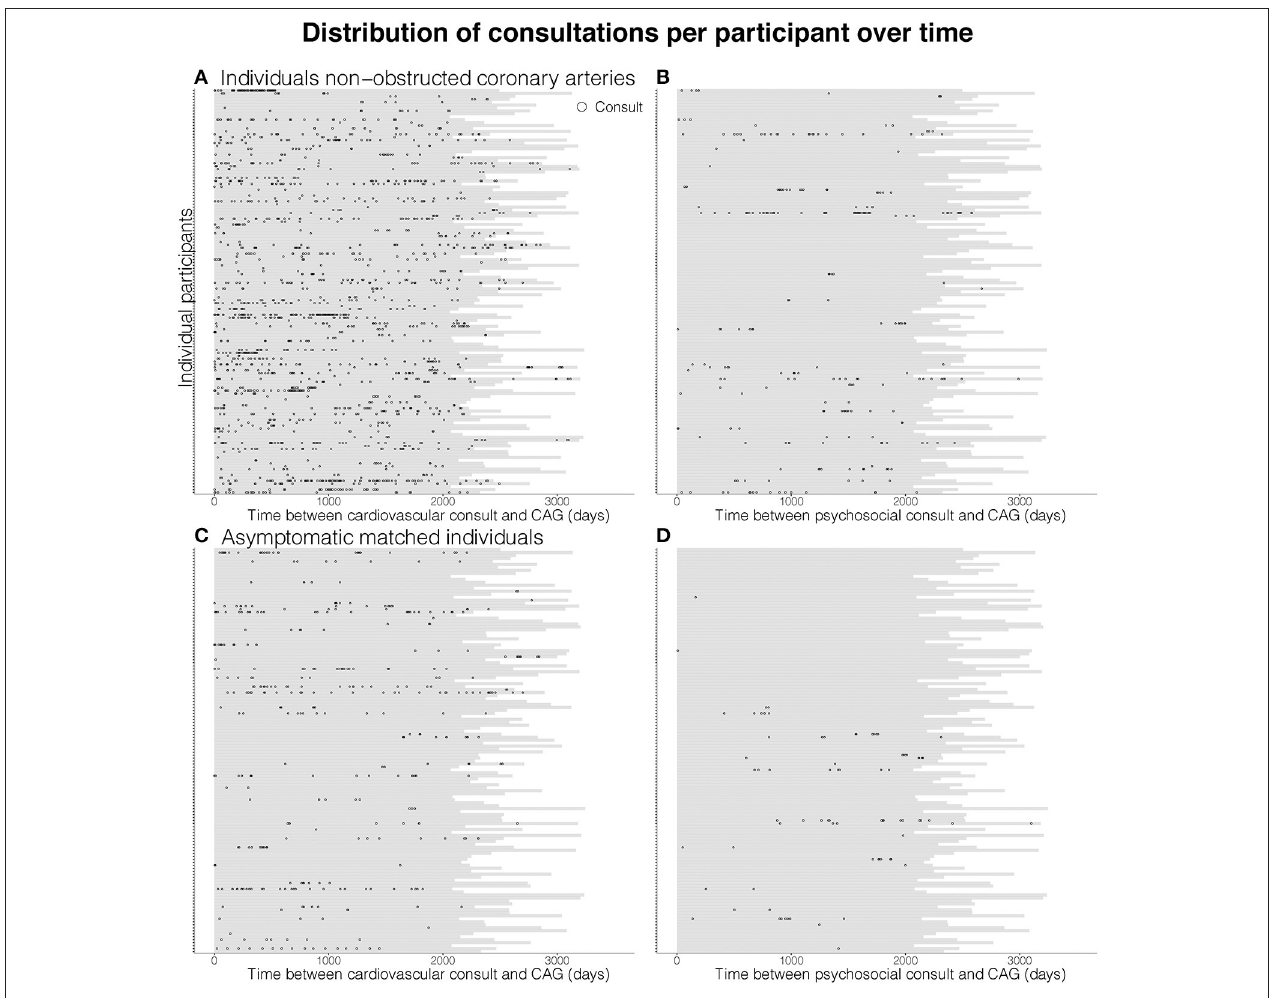
FIGURE 2 | Visualization of cardiovascular (left) and psychological (right) consultations during follow-up after coronary angiography in women and men with non-obstructed coronary arteries (panel A , respectively, B ) and matched asymptomatic men and women (panel C , respectively, D ). Each horizontal bar represents the follow-up period in days of one individual participant and each dot represents a general practitioner